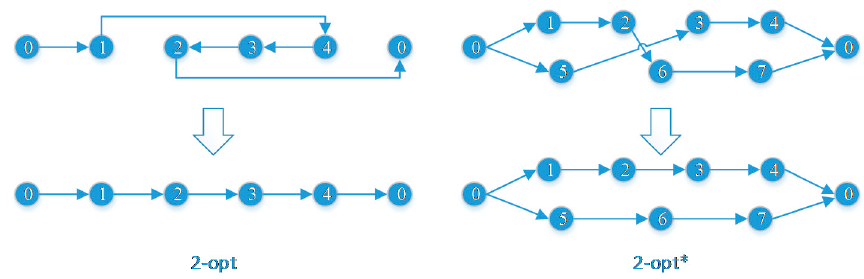
Figure 3. Illustration of operators in the later perturbation.